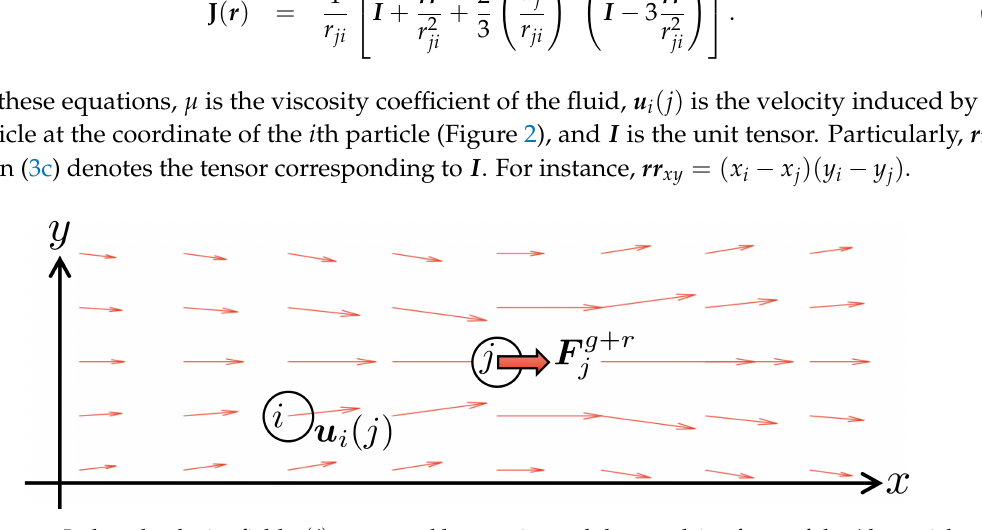
Figure 2. Induced velocity field u ( j ) generated by gravity and the repulsive force of the j th particle, + r F g , using Equation (3b). According to the force direction, the ambient fluid is pushed and pulled as j shown by the arrows. The induced velocity at the i th particle is expressed as u i ( j )